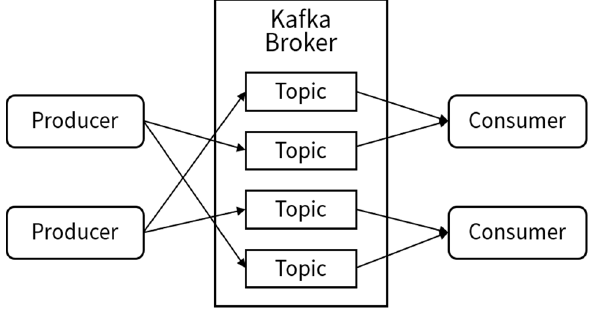
Figure 3. Kafka system architecture.